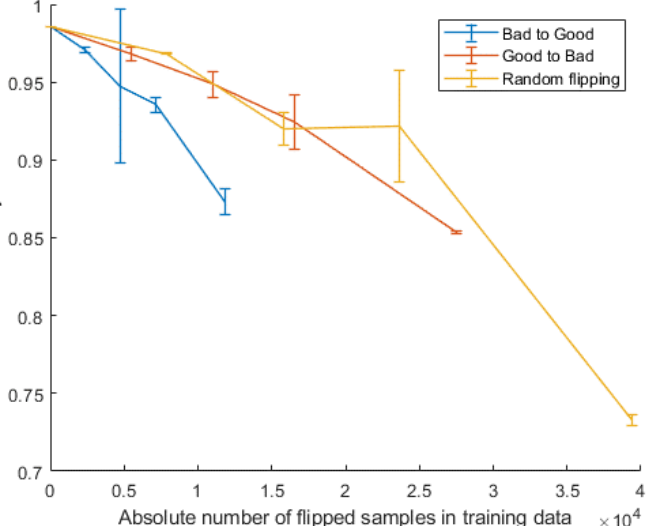
Figure 3. Impact of the absolute number of mislabeled records upon the best learning model on the cleanest training set from the previous work [17,18]. The three types of label noise were used and the performance degradation was verified, with different slopes accordingly to the type of noise induced.